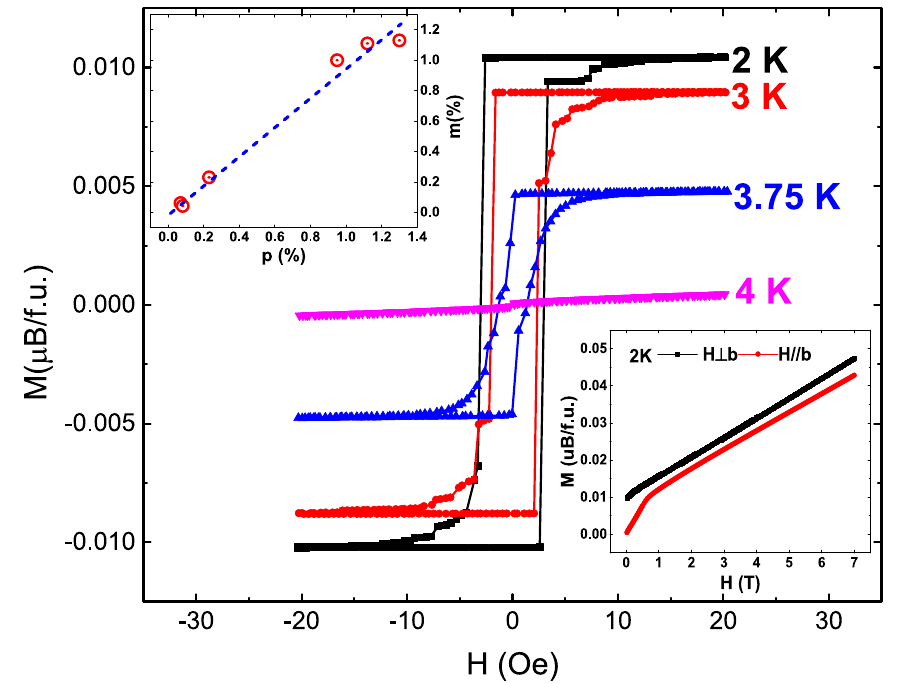
Figure 3. Magnetization ( M ) versus applied field ( H ) at four different temperatures for H ⊥ b . Top inset: paramagnetic term ratio ( p ) of six different samples obtained by fitting Eq. (2) versus the ratio of the ferromagnetic saturation magnetic moment to that of Cu 2+ ( m = M S / M Cu 2 + ). The dotted line represents the linear fitting to the data. Bottom inset: M – H curve at 2 K for H ⊥ b and H //b